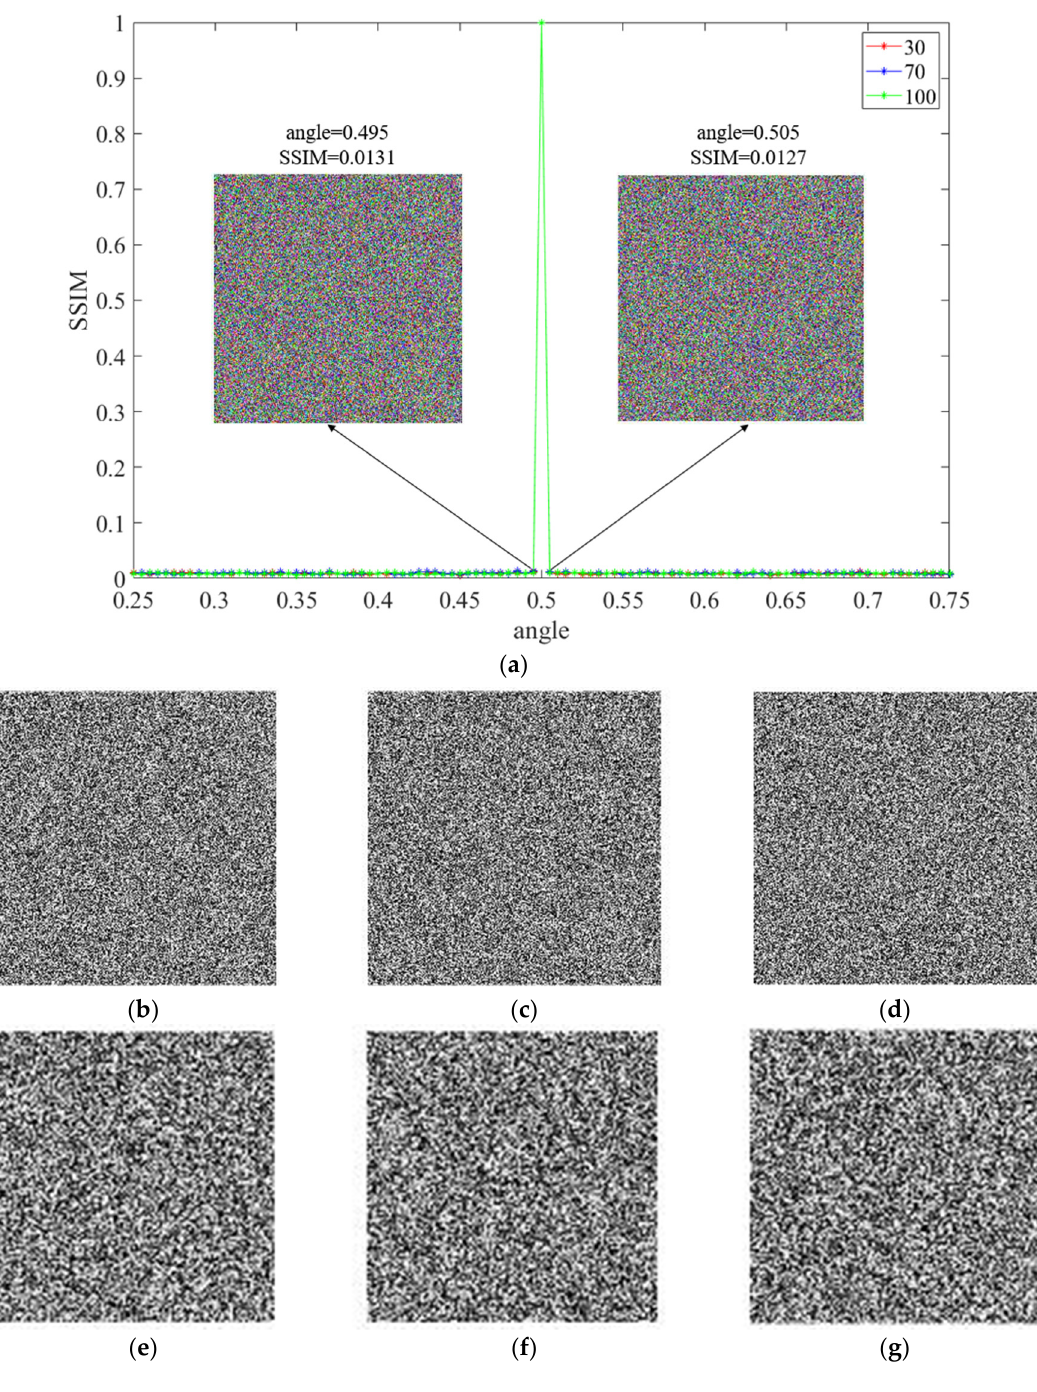
Figure 10. ( a ) the SSIM curve calculated by the different values of the parameter of the Gyrator ( b – d ) corresponding decrypted image of 30th, 70th and 100th band with angle = 0.495; ( e – g ) corre- sponding decrypted image of 30th, 70th and 100th band with angle = 0.505.